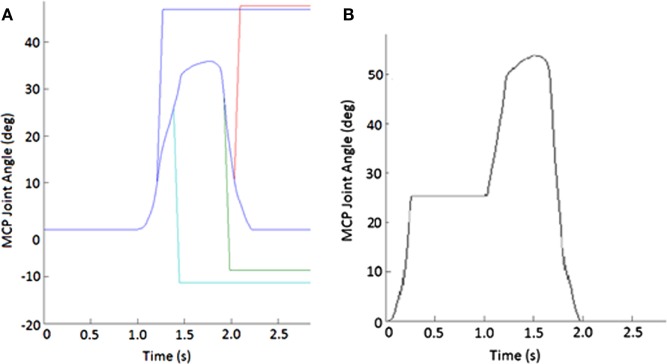
Example of perturbations. (A) Displacement applied to metacarpophalangeal (MCP) joint to create stretch of finger muscles. Blue line shows unperturbed subject-specific trajectory while the other lines show flexion (increasing angle) or extension (decreasing joint angle) or extension imposed during either the closing or opening phase of movement. (B) Impedance of MCP joint suddenly increased for 750 ms during the closing phase of the pinching task.